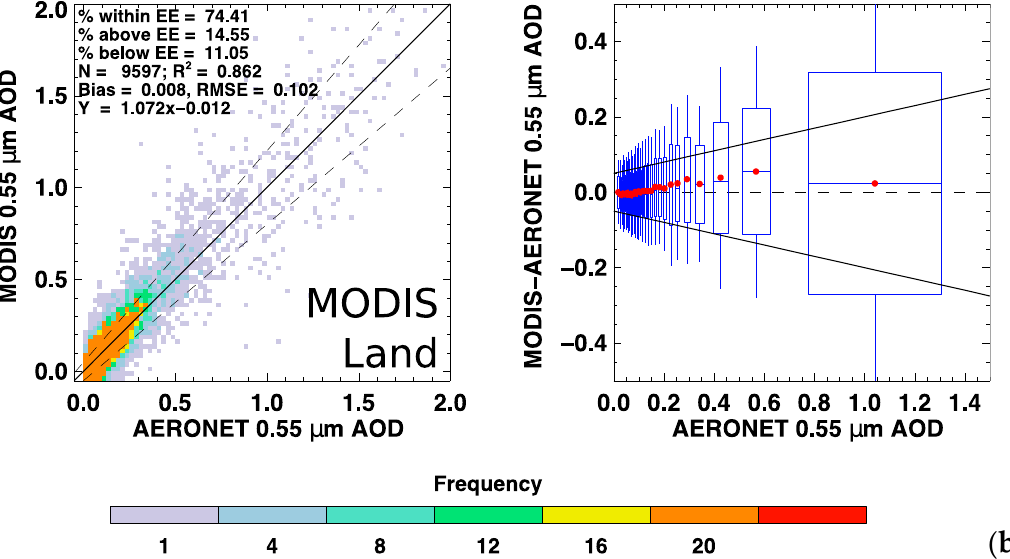
Figure 2. Comparison between Dark Target and AERONET for 0.55 µ m AOD over land for all collocated measurements in 2015 using ( a ) VIIRS SNPP and ( b ) MODIS Aqua.